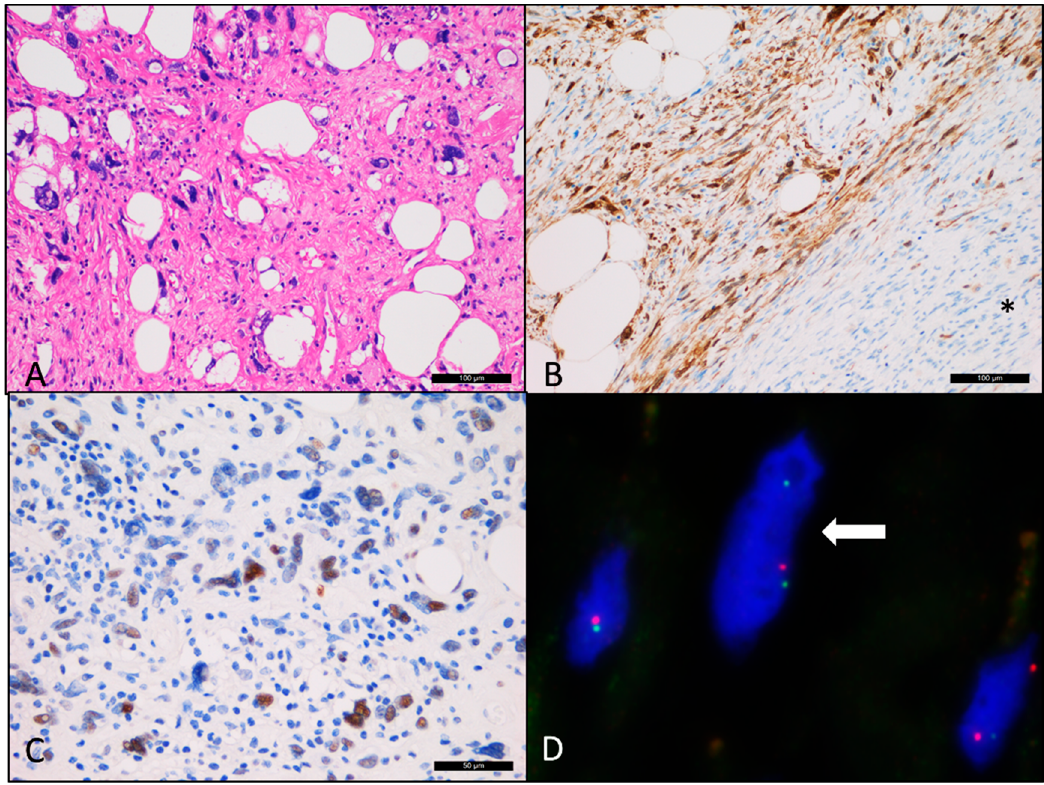
Figure 2. Cellular angiofibroma with sarcomatous transformation (case 6). ( A ) Sarcomatous area showing morphology similar to pleomorphic liposarcoma. ( B ) Diffuse p16 immunopositivity compared with the typical cellular angiofibroma regions labeled as “*” (negative). ( C ) The atypical cells showing positivity for p53. ( D ) Deletion of the RB1 gene region (single red dot) detected by fluorescence in situ hybridization